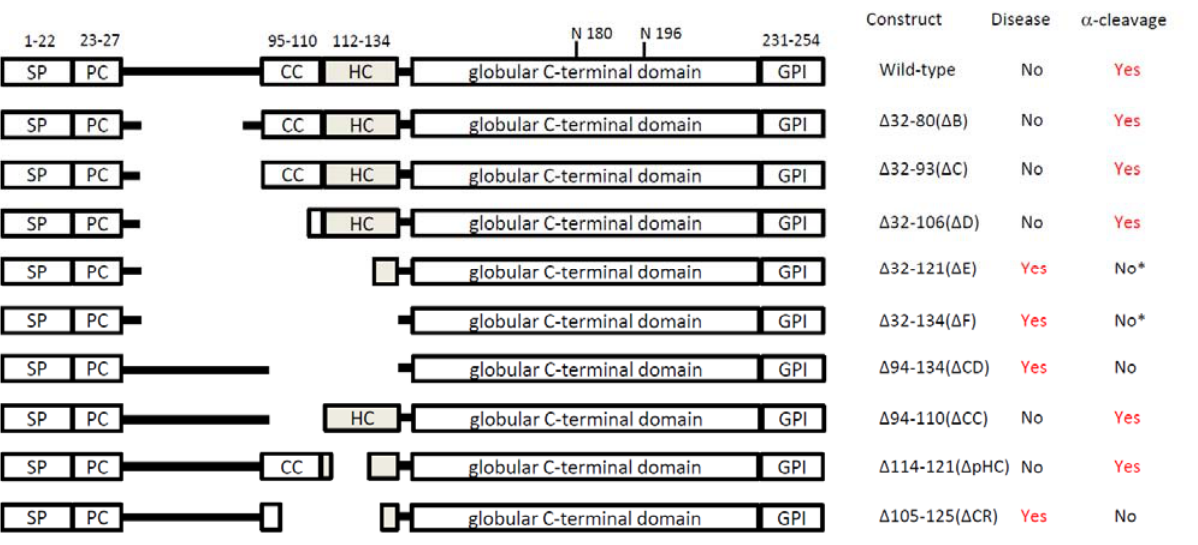
Figure 2. Schematic of PrP constructs and comparison of  -cleavage. All